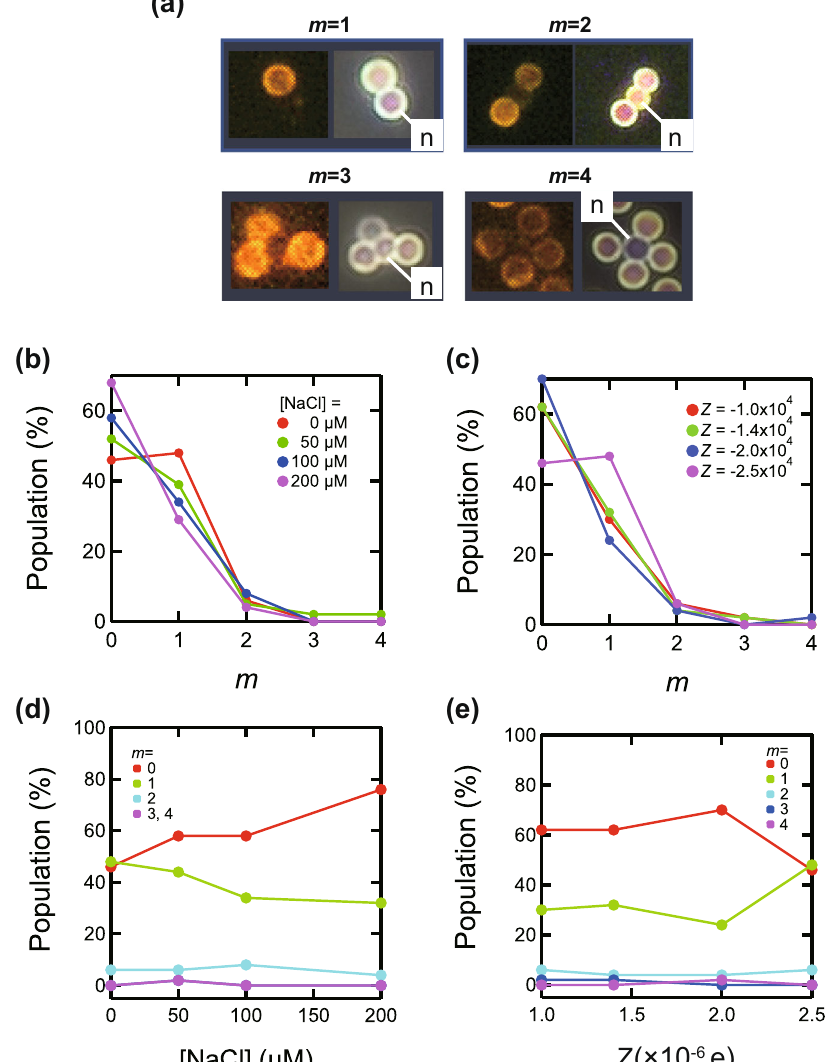
Fig. 7 Microscopic images of titania clusters and distribution of association number. a Magni fi ed images of titania-based clusters from m = 1 to m = 4 (left and right images with red fl uorescence only detected and white light source, respectively). Distribution of the number of clusters m in the titania-based sample. b [NaCl]-dependence and c Z -dependence. d [NaCl] dependence and e Z -dependence of the proportion of m = 0 to m = 4